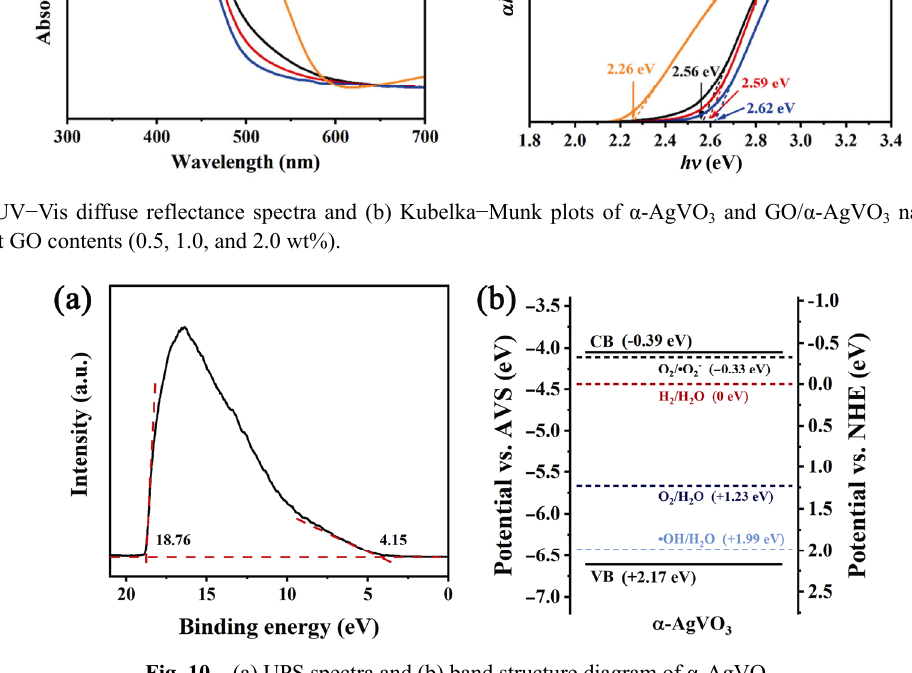
Fig. 10 (a) UPS spectra and (b) band structure diagram of α -AgVO 3